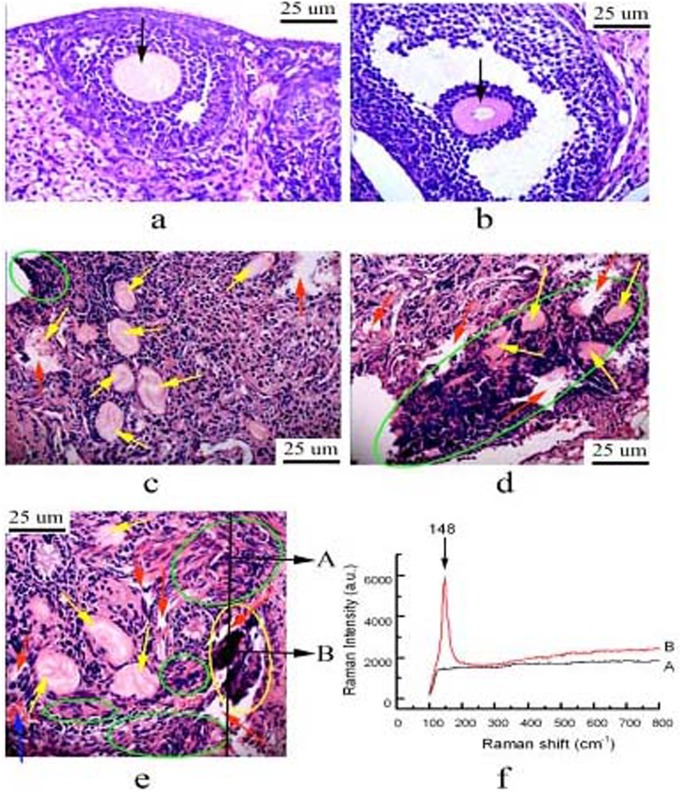
Histopathological observation of ovary of mice caused by intragastric administration of nano-TiO2 for 90 consecutive days.(a) control groups (unexposed mice) present normal development of primary follicle and secondary follicle; (b) 2.5 mg/kg nano-TiO2-exposed group: green cycle suggest inflammatory cell infiltration, yellow arrows indicate atretic follicle, red arrows present apoptosis or tissue necrosis; (c) 5 mg/kg nano-TiO2-exposed group: green cycle suggest severe inflammatory cell infiltration, yellow cycles present nano-TiO2 deposition, yellow arrows indicate atretic follicle, red arrows present apoptosis or tissue necrosis in ovary; (d) 10 mg/kg nano-TiO2 -exposed group: green cycle suggest severe inflammatory cell infiltration, yellow arrows indicate atretic follicle, red arrows present tissue necrosis, yellow cycle may show aggregation of nano-TiO2 in ovary. Arrow A spot is a representative cell that not engulfed the nano-TiO2, while arrow B spot denotes a representative cell that loaded with nano-TiO2. The right panels show the corresponding Raman spectra identifying the specific peaks at about 148 cm−1.